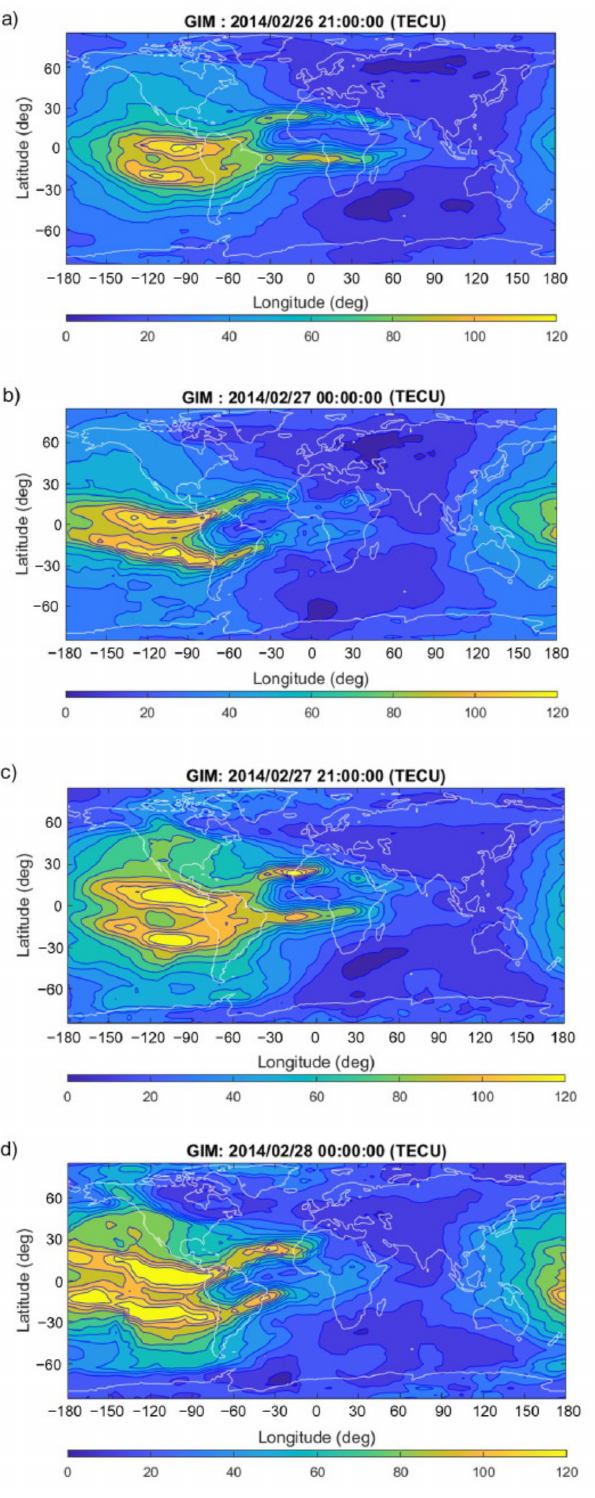
Figure 7. GIMs obtained in ( a , b ) quiet conditions previous to the geomagnetic storm and ( c , d ) in the hours of most disturbed geomagnetic conditions during the main phase (21–00 UT) of the 26–27 February 2014 geomagnetic storm. Colours indicate the values of vTEC in TECU. On the right panels, a zoom of the region of interest (Iberian Peninsula and Western North Africa) is